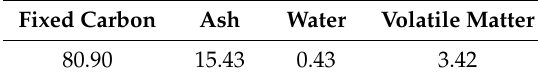
Table 3. Chemical analysis results of the graphite ore (air-dried basis; %).